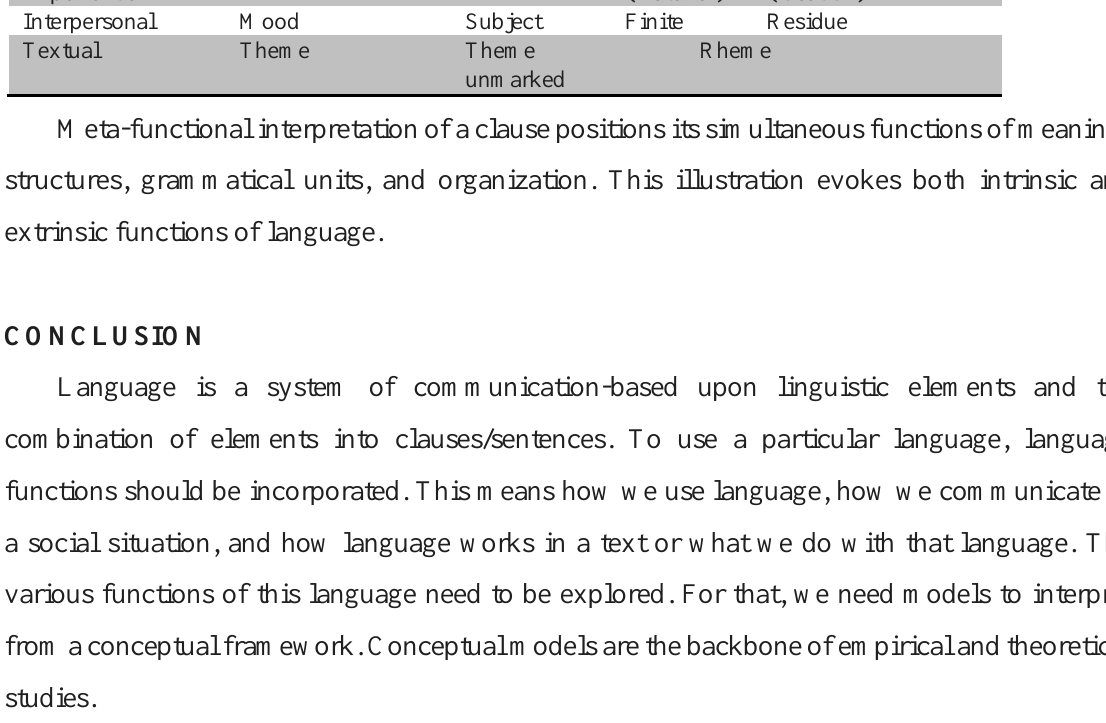
Table 2: Metafunctional Interpretation of a Clause